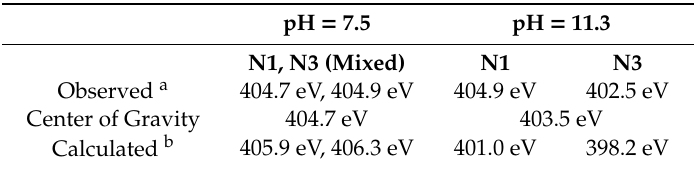
Figure 2. X-ray photoelectron spectra of UMP for solutions of pH = 7.5 and 11.3 at the photon energy of 520 eV. Vertical bars indicate the theoretical ionization potentials (IPs) of the N1 1s and N3 1s orbitals (see text). Table 1. Observed and calculated N 1s ionization potentials for aqueous uracil moiety. The observed results are for aqueous UMP in XPS at a photon energy of 520 eV and the calculated results for comparison are for isolated Meura (see text).